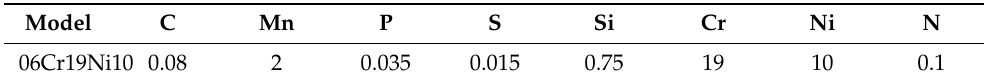
Table 1. The chemical composition of the stainless steel (at.%).